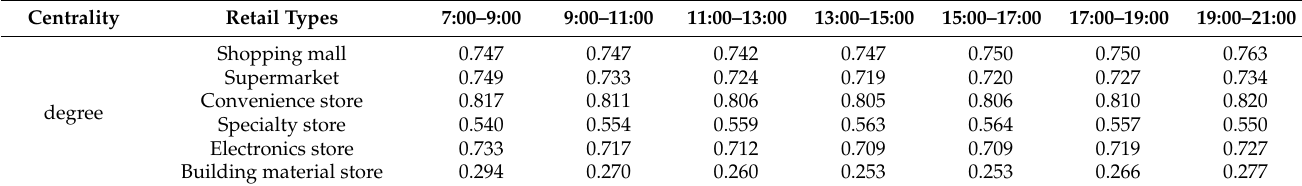
Table 5. Correlation coefficients of KDE values of stores and weighted centrality indices for each period on weekends.